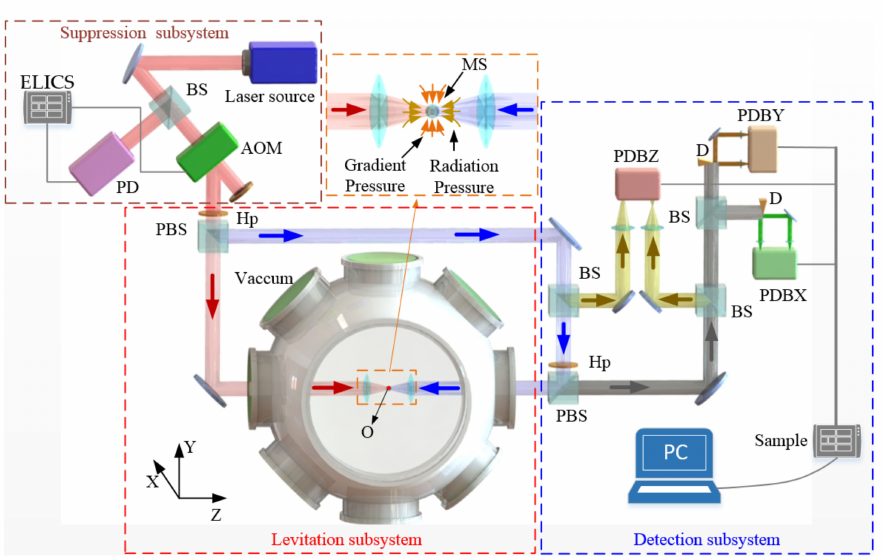
Figure 6. Schematic of a dual-beam optical trap with laser intensity fluctuation suppression. The abbreviations are: BS, beam splitter; PBS, polarization beam splitter; PD, high-speed photodiode; ELICS, external laser power control system; Hp, half-wave plate; MS, microsphere; D, D shape mirror; PDBX,PDBY and PDBZ, photoelectric balance detector to detect the motion of MS along the X , Y , Z axes,